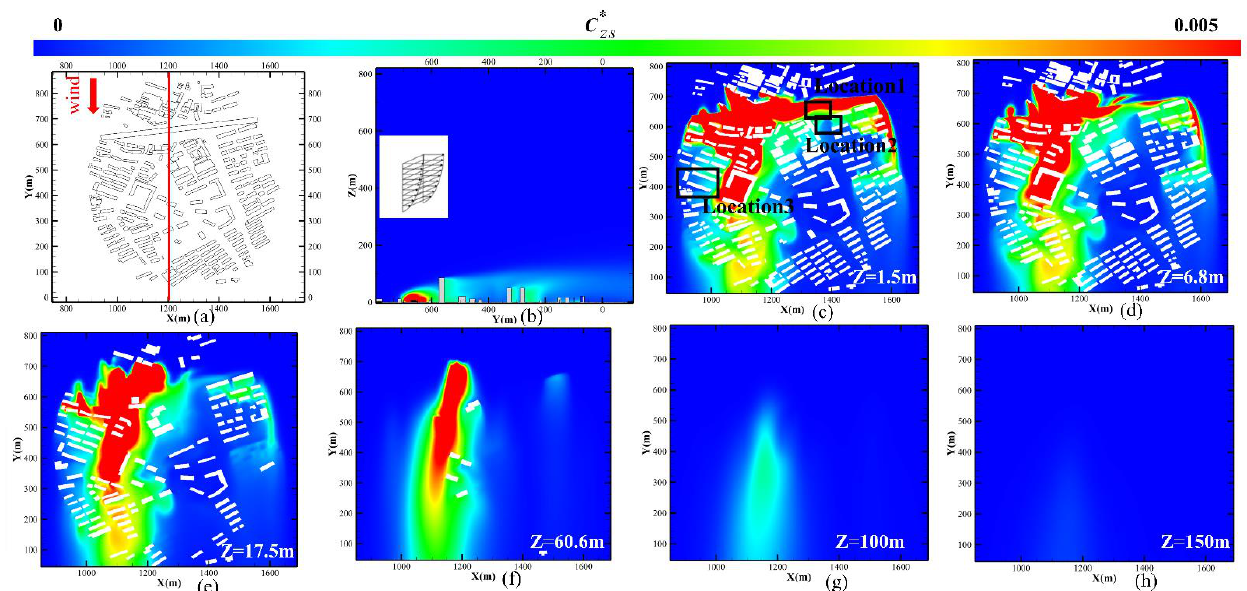
Figure 7. Contours of normalized pollutant concentration ( C *) at planes 𝑥 = 1224 m, z = 1.5 m, z = 6.8 m, z = 17.5 m, z = 60.6 m, z = 100 m and z = 150 m of ground – level ( a – h ).